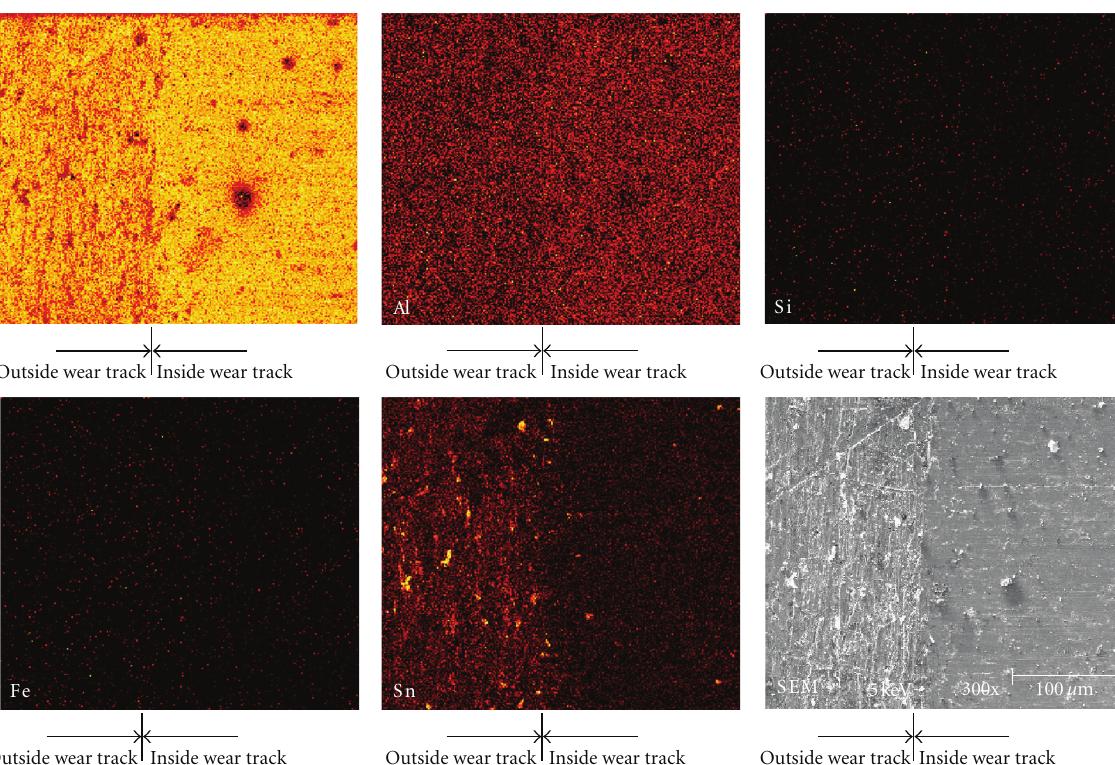
Figure 9: Chemical mapping by AEX (GMO in PAO for 120 min).